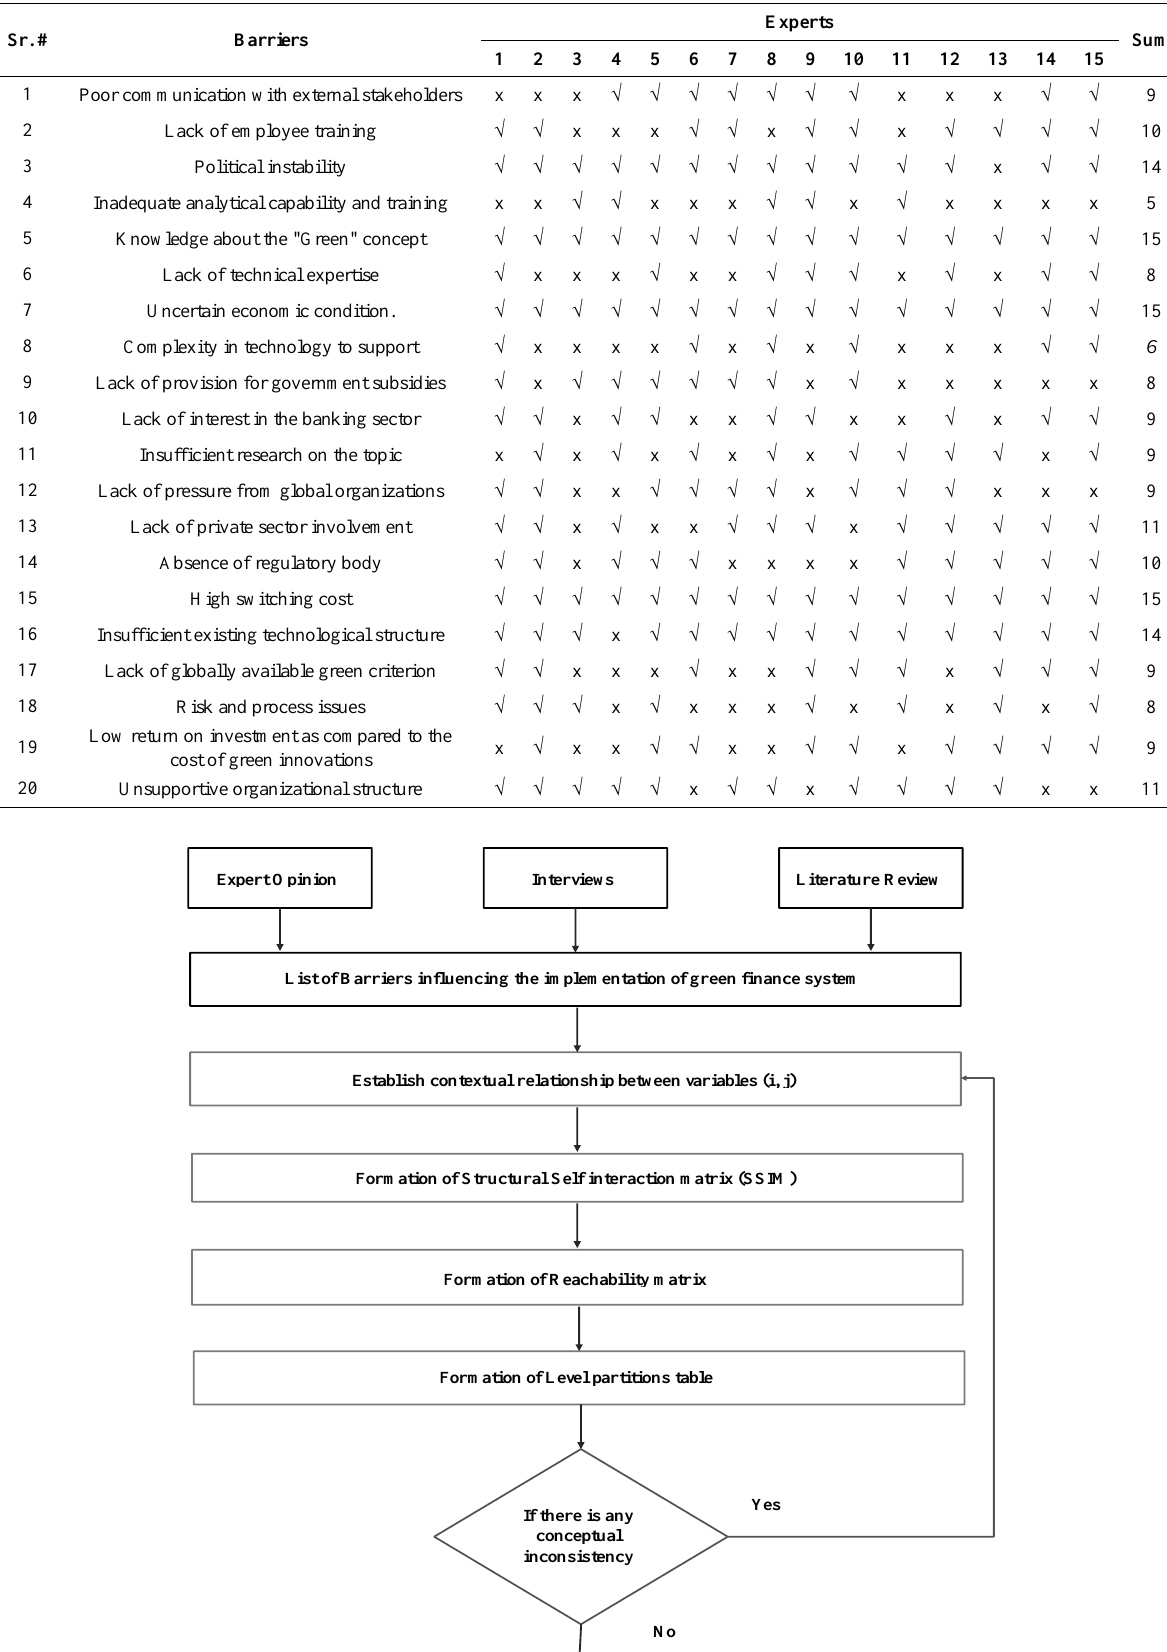
Table 3. Verification of barriers by experts